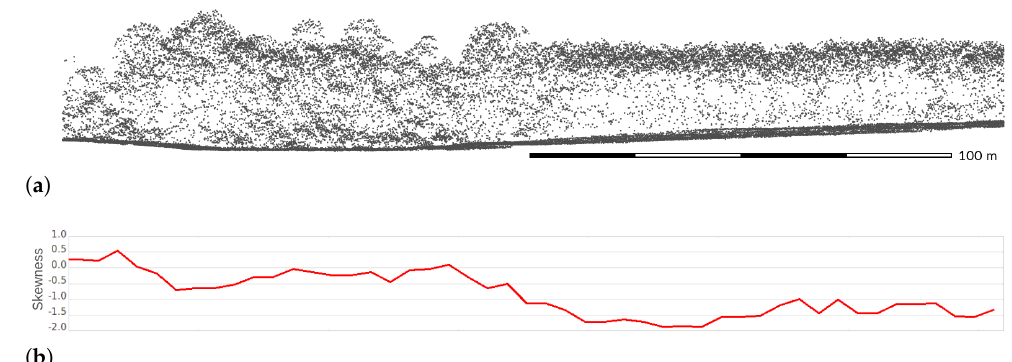
Figure 13. ( a ) Vertical distribution of lidar points in natural forest (left) and a planted forest (right) in a 220 m long and 30 m wide transect of a forested area. ( b ) Skewness of point elevations along the same transect without ground points. Dataset: NC Floodplain Mapping Program 2015